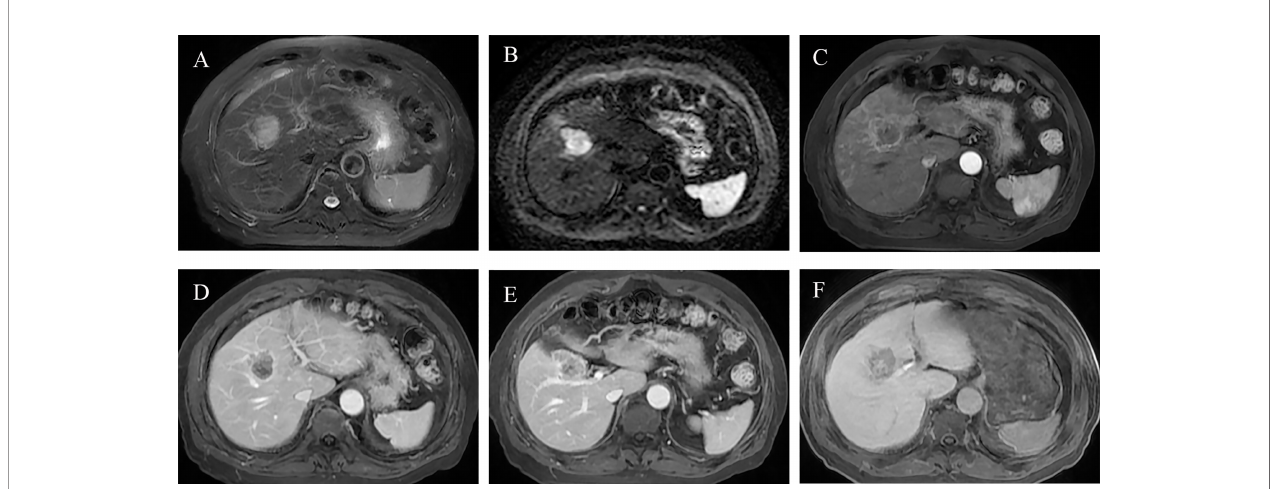
FIGURE 6 | Preoperative MR images of early recurrence after anatomical hepatectomy in patients with hepatocellular carcinoma. A 72-year-old male with AFP-L3, PT, and GGT levels (negative, 10.7 s, 38 U/L) was hospitalized due to abdominal discomfort. Before operation, Gd-BOPTA MRI found a 3.7-cm lesion in hepatic segment V, with typical HCC features: mild hyperintensity on T2-weighted imaging (A) , hyperintensity on diffusion-weighted imaging (B) , and hypointensity on HBP (F) . Rim arterial phase hyperenhancement present (C) and incomplete radiological capsule enhancement (E) were risk factors of early recurrence in our study. Arterial peritumoral enhancement, an independent risk factor for early recurrence, was presented on arterial phase and portal phase (C, D) , white arrow). Peritumoral hypointensity on HBP ( F , white arrow), also an independent risk factor. After anatomical hepatectomy, postoperative follow-up presented that this patient suffered from intrahepatic distant recurrence at 3 months.